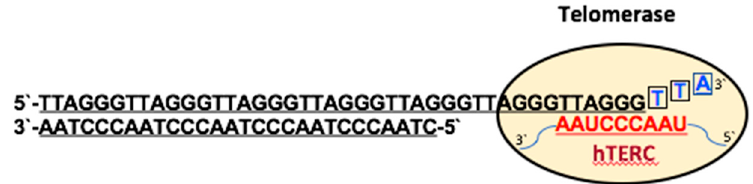
Figure 2. Schematic illustration of telomerase-dependent telomere elongation. Few nucleotides of the G-rich 3 ′ overhang pair with their complementary sequence in the telomerase RNA (hTERC) and the reverse transcriptase activity of hTERT extends the telomere using the hTERC as a template. The extended DNA terminus detaches from its RNA template, becoming available for another round of elongation by telomerase.